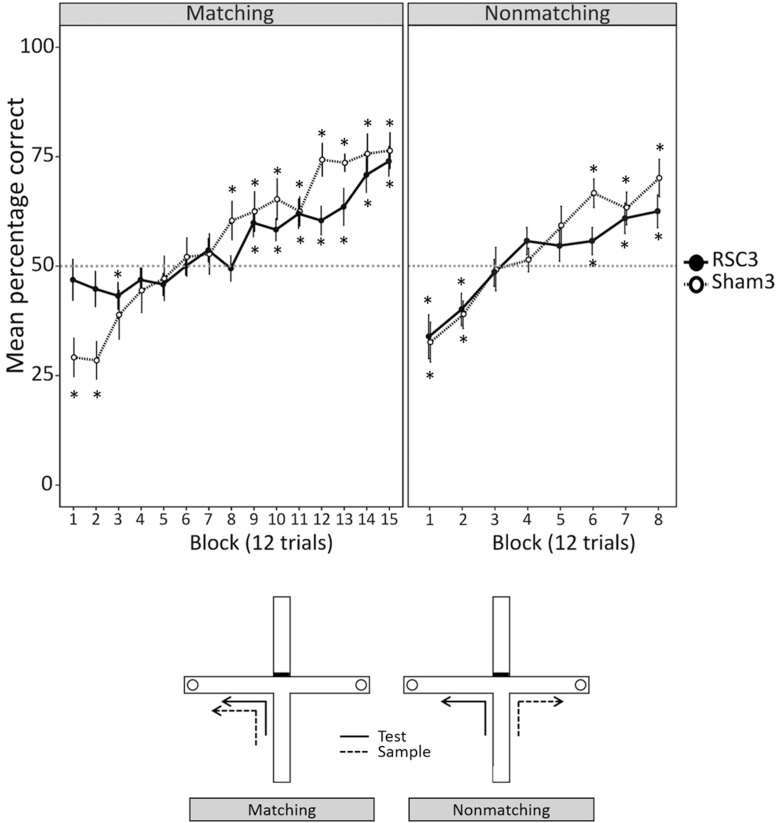
T-maze: matching and nonmatching (Experiment 4). The upper panels show the mean percentage correct scores across the matching (left panel) and nonmatching (right panel) tasks. The dotted line marks the chance performance level. Asterisks show when the performance of each group was significantly different from chance (p < 0.05; one sample t-test). Error bars show ±SEM. The lower panels depict the test protocols for the matching (left) and nonmatching (right) tasks in a T-maze. The circles correspond to food wells.